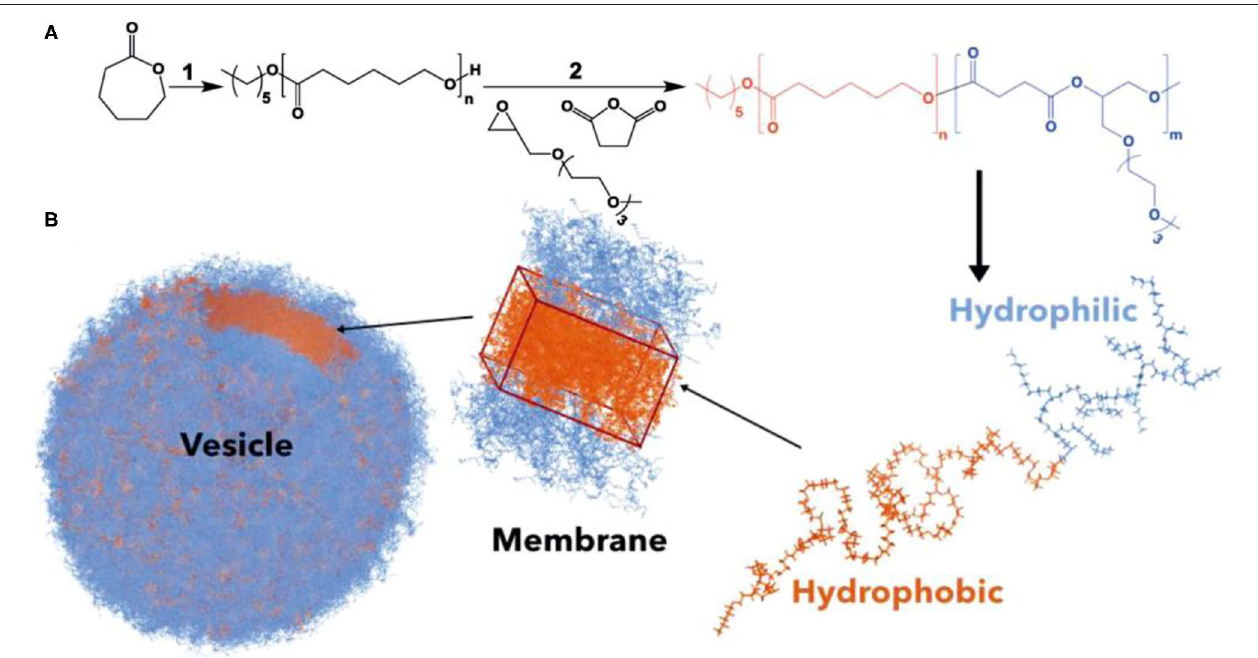
FIGURE 14 | (A) Synthesis of PCL- b -PE. (B) PCL- b -PE forms polymersomes via self-assembly. Adapted with permission from Zhu et al. (2019). Copyright 2019